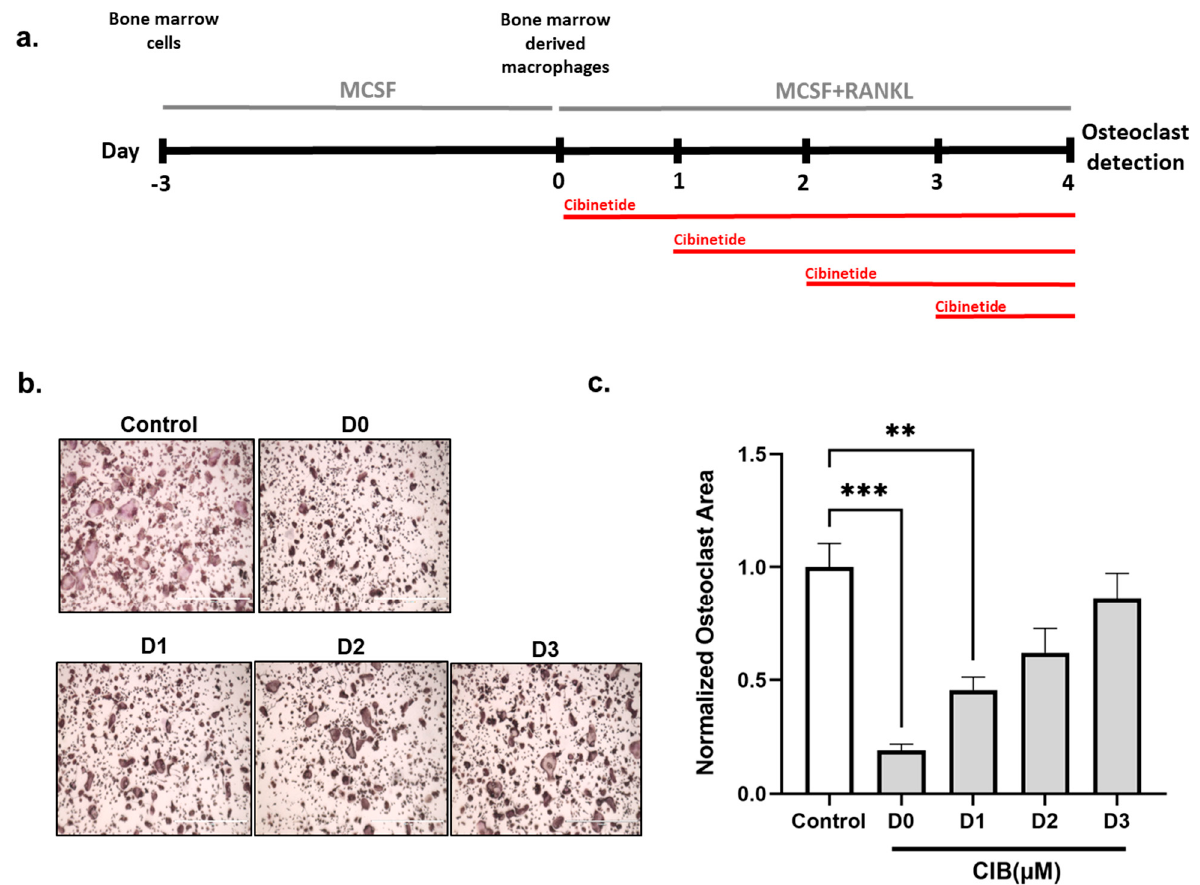
Figure 2. Cibinetide (CIB) inhibits osteoclastogenesis during the early stage of osteoclast differentiation in vitro. ( a ) Schematic representation of the experimental layout. ( b ) BMDM were treated with Cibinetide (150 µ M) at four different time points (indicated by red lines) in the presence of RANKL (50 ng/mL) and M-CSF (20 ng/mL). After four days, TRAP staining was performed. ( c ) Quantification of the total area of TRAP + multinucleated cells. Data from three independent experiments are shown as mean ± SEM. ** p < 0.01, *** p < 0.001.